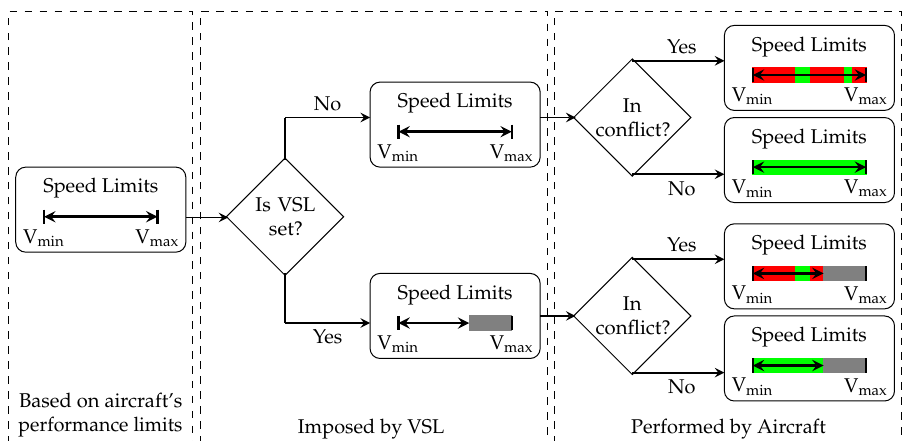
Figure 1. Prioritisation of rules over speed choice. Hard limits are first imposed by an aircraft’s performance limits. If set, the variable (maximum) speed limit (VSL) must be respected. Additionally, aircraft perform conflict avoidance. A conflict-free (displayed in green), allowed speed value is then picked.